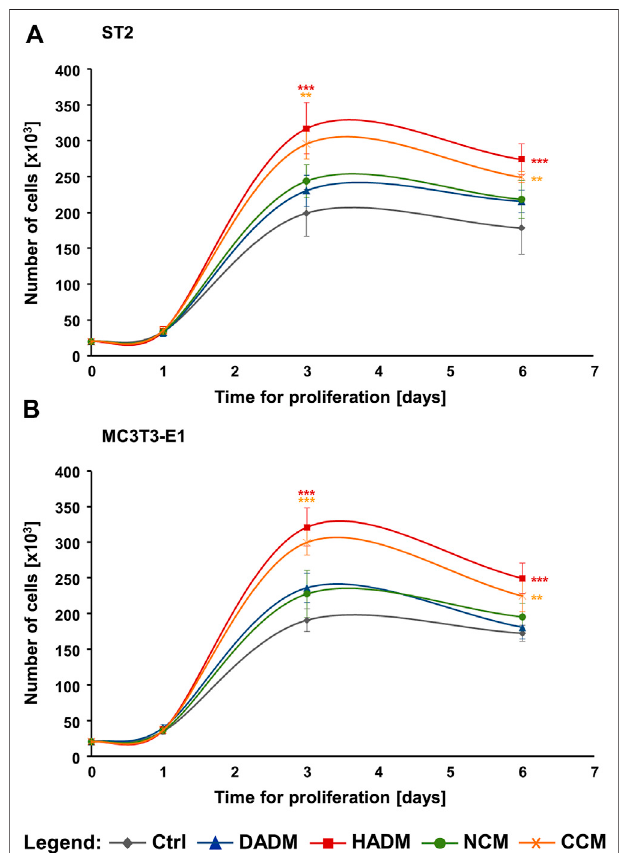
FIGURE 2 | Strongly induced proliferation of osteoprogenitor cell lines grown on HADM and CCM collagen-based matrices. Proliferation rates